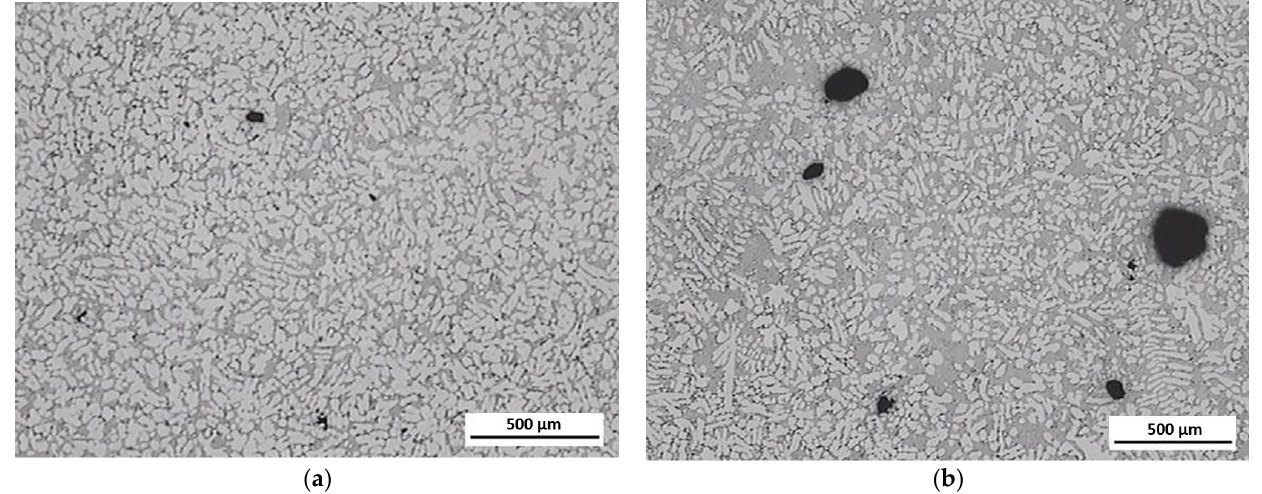
Figure 11. Comparison of the presence of pores in the microstructure of ZnAl4Cu3 alloy: ( a ) after first remelting (P1 alloy) and ( b ) after ninth remelting (P9 alloy).